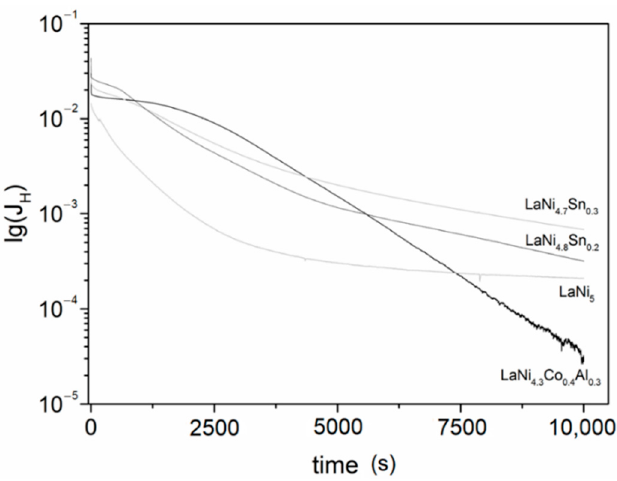
Figure 8. “lg( J H ) vs. discharge time t ” during potentiostatic discharge of LaNi 5 type alloys. Table 2. Hydrogen diffusion coefficients for the LaNi 5 based alloys.